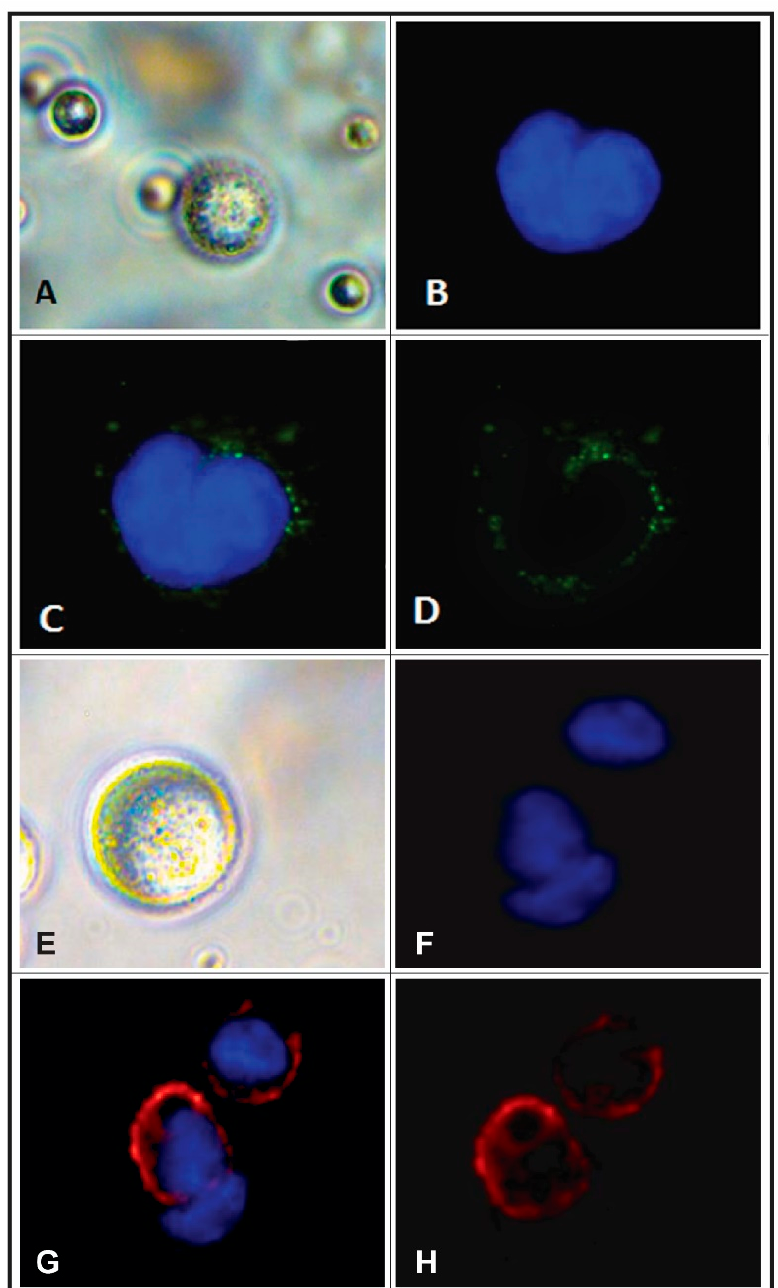
Figure 1. ( A ) Phase contrast micrograph demonstrating bead-isolated CTCs (40 × magnitude). ( B ) Fluorescent micrograph of a DAPI (4 ′ ,6-diamidino-2-phenylindole) stained CTC nucleus. ( C ) Indirect immunofluorescence (IF) micrograph demonstrating overlapping DAPI-stained CTC nucleus (blue) and CK (cytokeratin, green) fluorescein isothiocyanate (FITC) IF, and ( D ) CTC CK IF (green), alone. ( E ) Phase contrast micrograph demonstrating bead-isolated peripheral blood leukocytes (PBL) (40 × magnitude). ( F ) Fluorescent micrograph of a DAPI (4 ′ ,6-diamidino-2-phenylindole) stained PBL nucleus. ( G ) Indirect IF micrograph demonstrating overlapping DAPI-stained PBL nucleus (blue) and protein tyrosine phosphatase receptor C (CD45) (red) FITC IF, and ( H ) PBL CD45 IF (red), alone. CTCs were also assayed for epidermal growth factor receptor (EGFR), vascular endothelial growth factor receptor (VEGFR), tumour protein p53 (p53), multidrug resistance (MDR1), thymidylate synthase (TYMS), dihydrofolate reductase (DHFR), serine hydroxy-methyltransferase 1 (SHMT1), DNA excision repair protein (ERCC1), and glutathione S-transferases (GST) mRNA expression (Table 3) and, based upon a CTC VEGF expression level >65% compared to peripheral blood mononuclear cells (PBMCs), bevacizumab was selected and administered to two patients, and one patient with BRCA1 mutation received rucaparib.